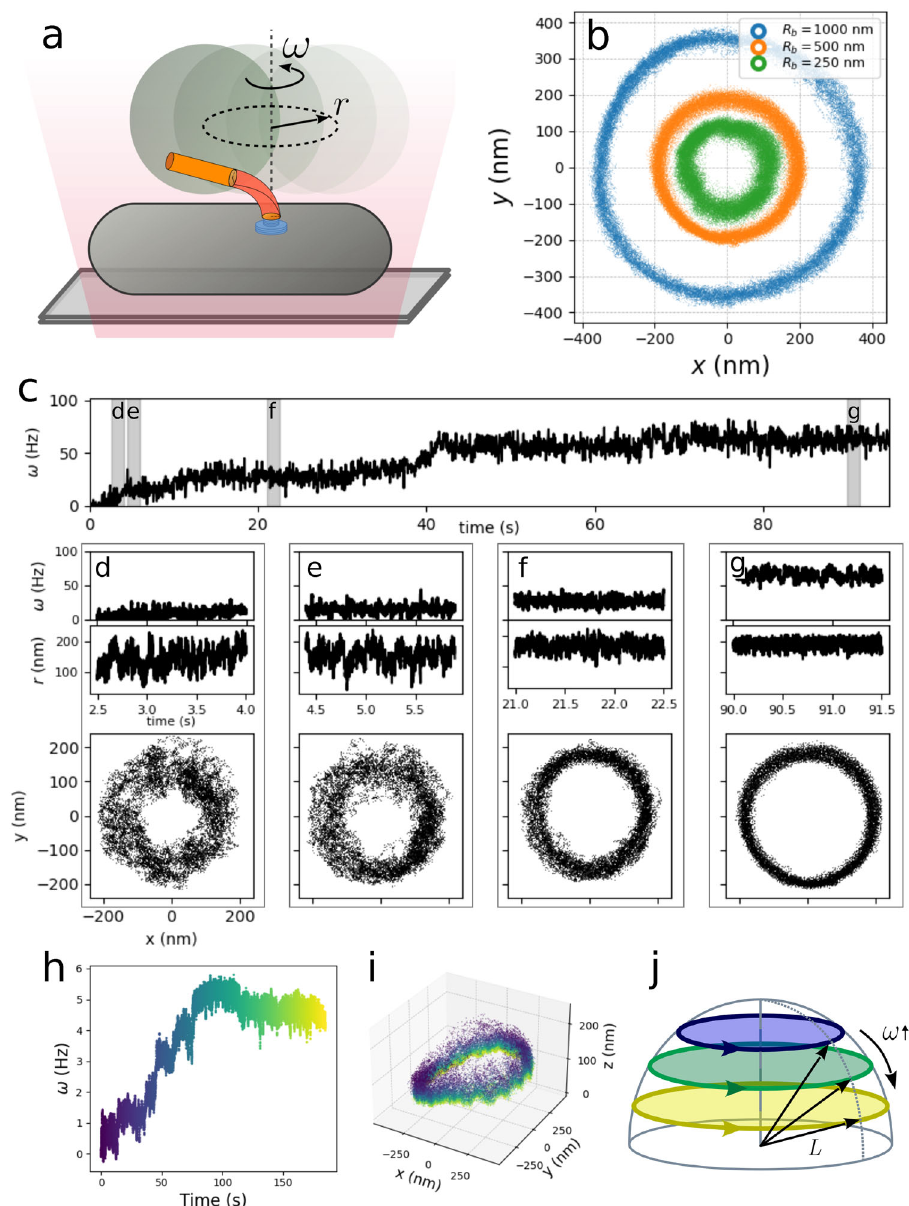
Fig. 1 Bacterial Flagellar Motor bead assays. a Schematic experimental setup (not to scale). A living bacterium is adhered to the microscope glass slide, and one microscopic bead is attached to the fi lament stub, rotating on an approximately circular trajectory, observed by optical microscopy and tracked at 8 – 10 kHz sampling rate. b Experimental x , y trajectories of the bead center obtained for beads of different diameter. c Resurrection trace ( R b = 500 nm, to increase readability the trace is here fi ltered with a 8 ms running window median fi lter). Along the time trace of the motor speed ω ( t ), four time-windows are highlighted, and for each window the corresponding signals ω ( t ), radius r ( t ), and the bead trajectory ( x ( t ), y ( t )) are shown in the respective d – g . The decrease in radial fl uctuations at increasing speed is particularly evident. h A resurrection trace (from a different motor than in c ), where the color code indicates the time. i 3D tracked position of the bead corresponding to the measurement in h ), with the same color code for time. The bead starts far from the membrane for low ω and approaches it when rotating faster, tracing circles of larger diameter. The trajectory is tilted because of the presence of the cell body. j Schematic representation of the behavior of the trajectory in i . We simplify the geometry assuming that the bead center moves on circular trajectories on a hemispherical surface of fi xed radius L . The color code indicates time as in h and i